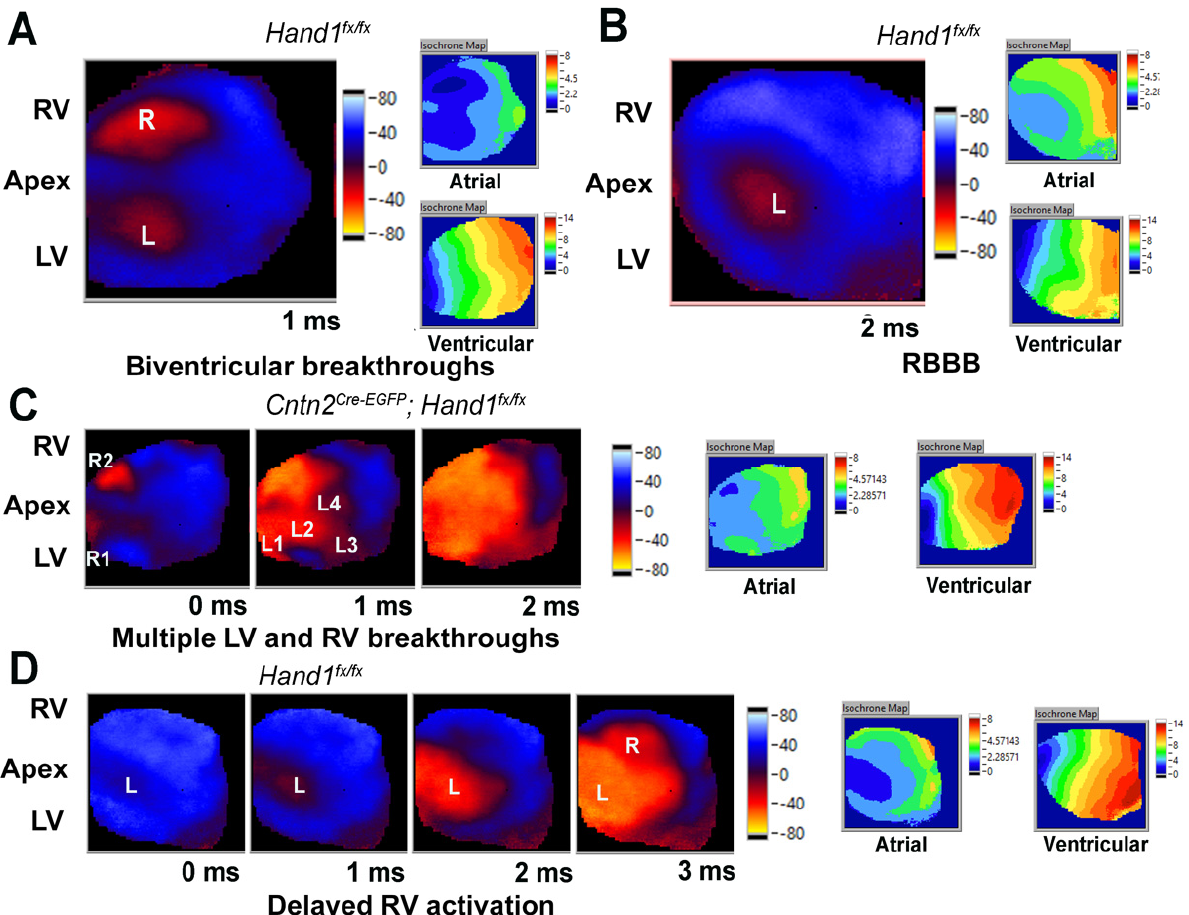
Figure 1. HAND1 function is not required for post-natal CCS homeostasis. Snapshots of representative epicardial voltage maps obtained during right atrial pacing (cycle length, 120 ms) in isolated-perfused H1CKO or H1control hearts. Isochrone activation maps during atrial and ventricular pacing (cycle lengths, 120 ms) are also shown for each heart. Number below each snapshot image is time in ms with 0 being the time of first epicardial breakthrough. Color codes for snapshots are in arbitrary units. Please note that membrane depolarization causes a decrease in the dye’s fluorescence intensity. Color codes for the activation maps are in ms. R, right; L, left. ( A ) Simultaneous and single LV (L) and RV (R) breakthroughs as expected in mature wildtype hearts. ( B ) Right BBB, left side epicardial breakthrough (L). ( C ) Multiple RV (R1, R2) and LV breakthroughs (L1–L4). ( D ) Delayed RV activation, RV epicardial breakthrough at 3 ms.